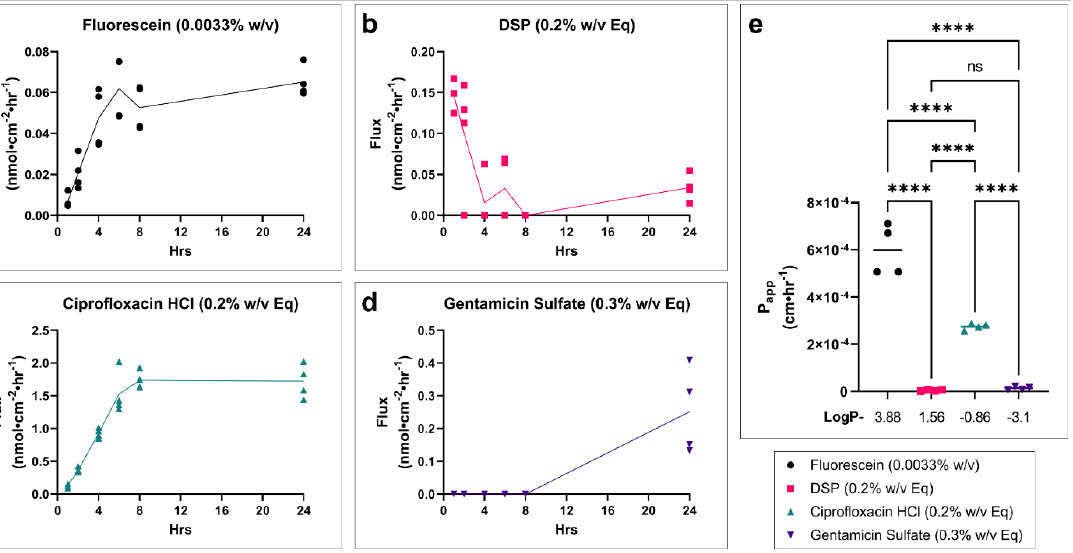
Figure 4. Drug permeability profiles and relative drug permeability for fully developed in vitro TM models. Drug flux of profile over time for ( a ) fluorescein, ( b ) DSP, ( c ) ciprofloxacin HCl, and ( d ) gentamicin sulfate in a fully developed TM model grown for 11 days at the air – liquid interface. n = 4. ( e ) Apparent permeability coefficient (P app ) at approximate steady-state conditions (average of 6 – 24 h timepoints), for each drug in the fully developed in vitro TM model. The log P of each drug is shown below x -axis. n = 4; one- way ANOVA with Tukey’s correction for multiple compari- sons; **** p < 0.0001. Legend applies to all panels. DSP, dexamethasone sodium phosphate; Eq, molar equivalent of base compound; TEER, transepithelial electrical resistance; P app , apparent permeability coefficient; w/v, weight by volume; ns, not significant.